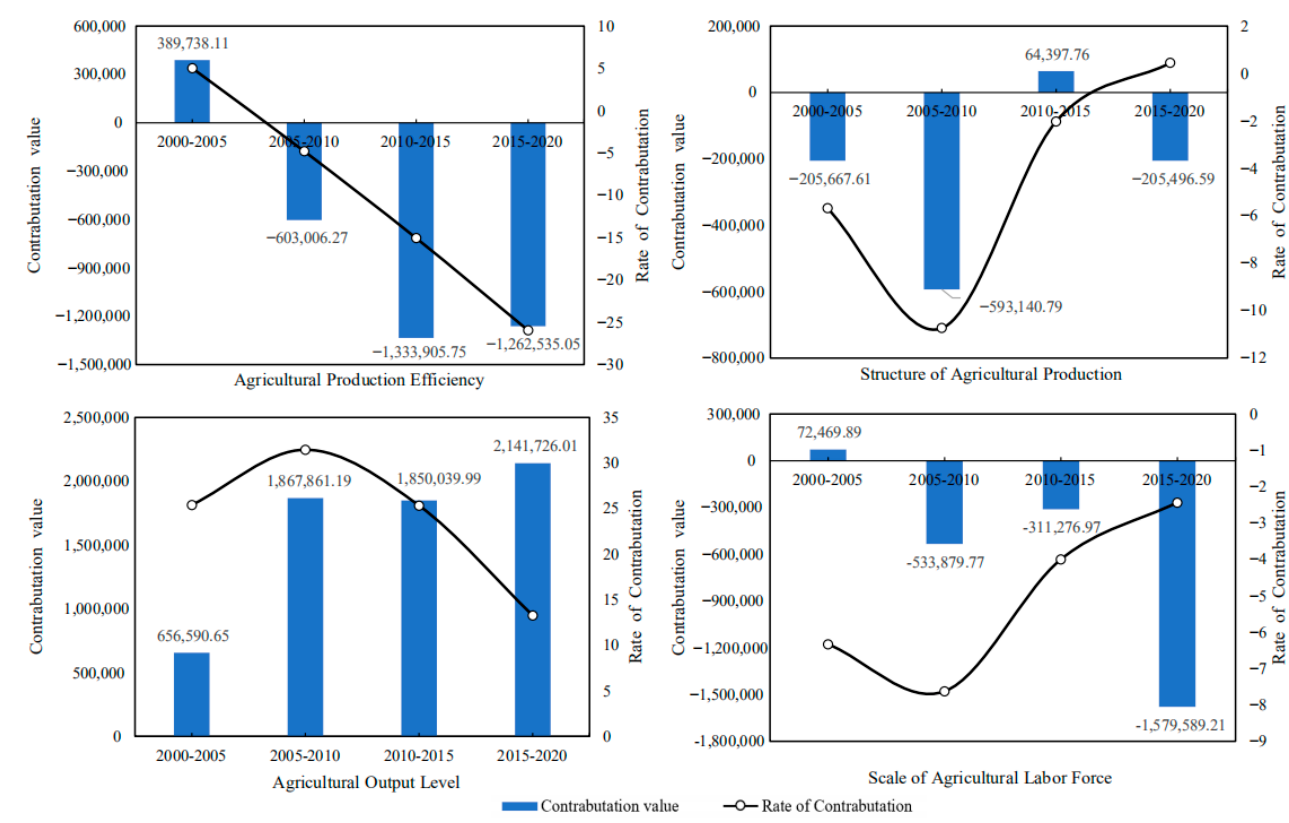
Figure 10. Contribution value and contribution rate of carbon emission drivers of cultivated land use in Hubei Province from 2000 to 2020 (including Agriculture Production Efficiency, Structure of Agriculture Production, Agriculture Output Level, Scale of Agricultural Labor Force).